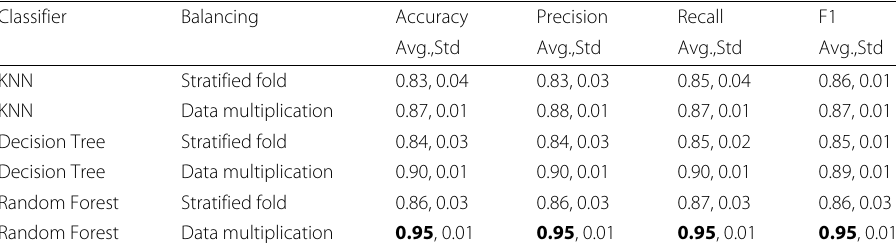
Table 2 Classification results according to the Intensity and Inequality features